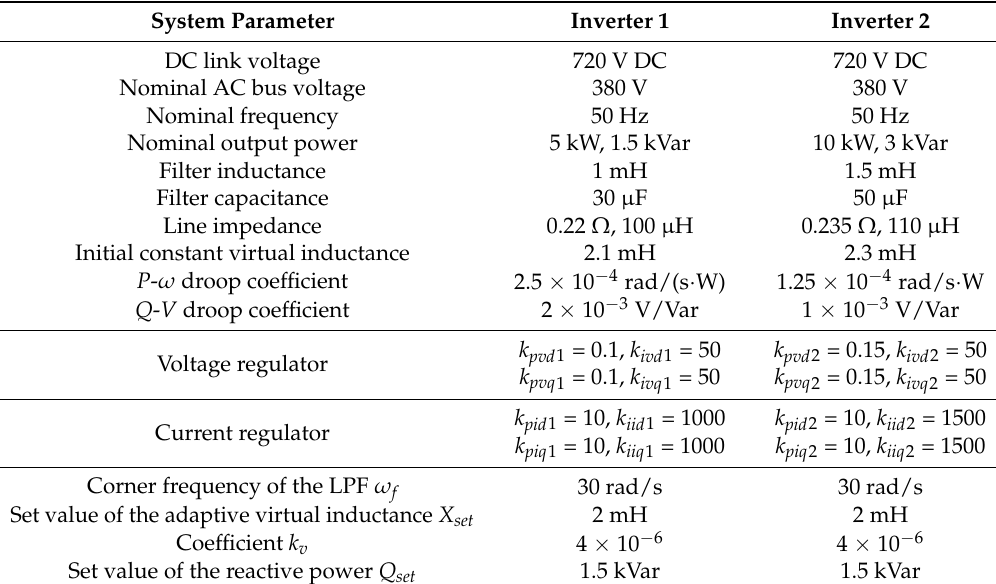
Figure 1. Microgrid composed of two DG inverters connected in parallel (example system). Table 1. System Parameters Used in Simulations and